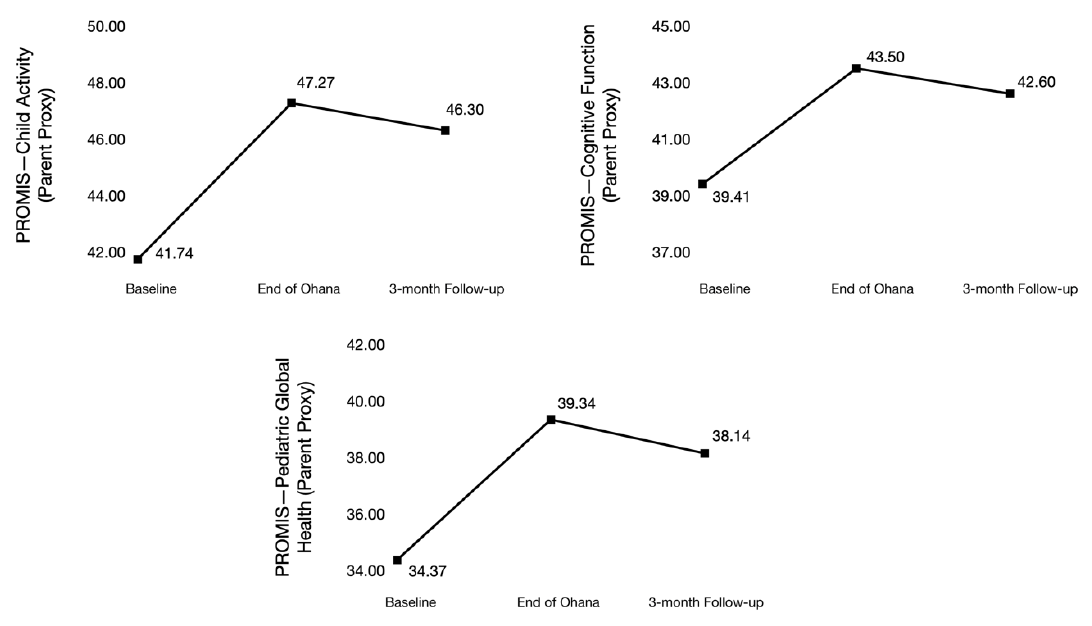
Figure 3. Changes in T-scores for exploratory outcomes for parents. PROMIS: the Patient-Reported Outcome System.